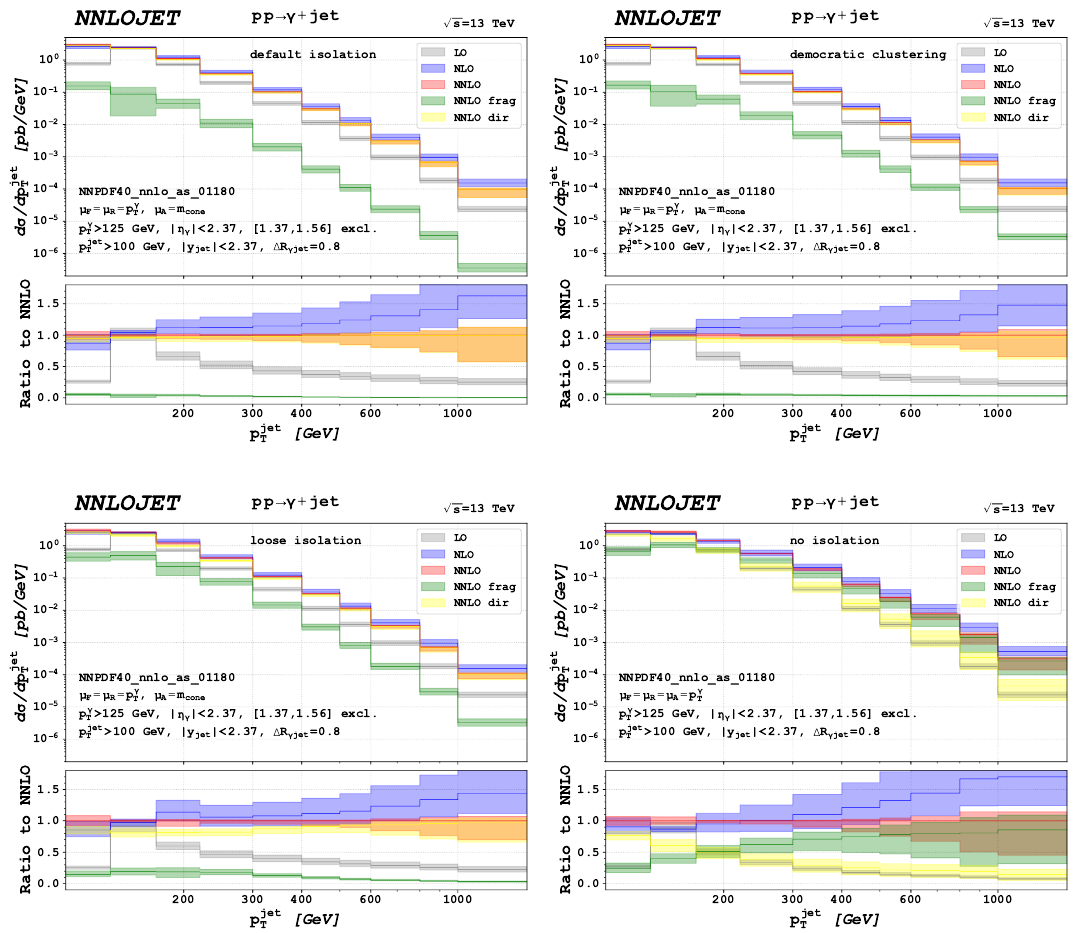
Figure 13. Decomposition of the cross section differential in the jet transverse momentum. Results obtained with the default isolation, a loose isolation, democratic clustering and without isolation are